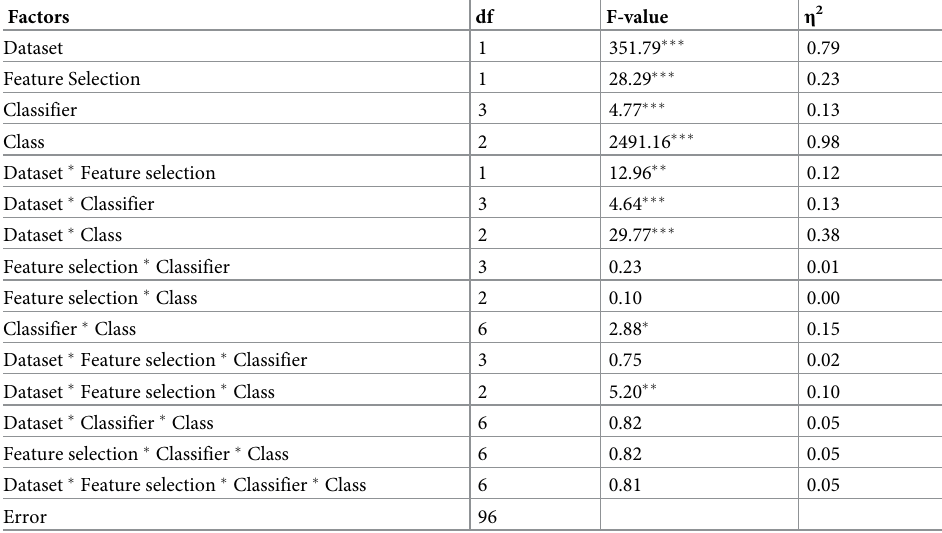
Error 96 Note: Dataset = recalibrated with child characteristics, major and minor behavior categories with or without environment data (ED); feature selection = with or without Boruta algorithm; classifier = XGB, SVM, RF or NN; class = class 2, 3 or 7; η 2 = partial eta squared; adjustment for multiple comparison (Bonferroni); p < 0.001 ���